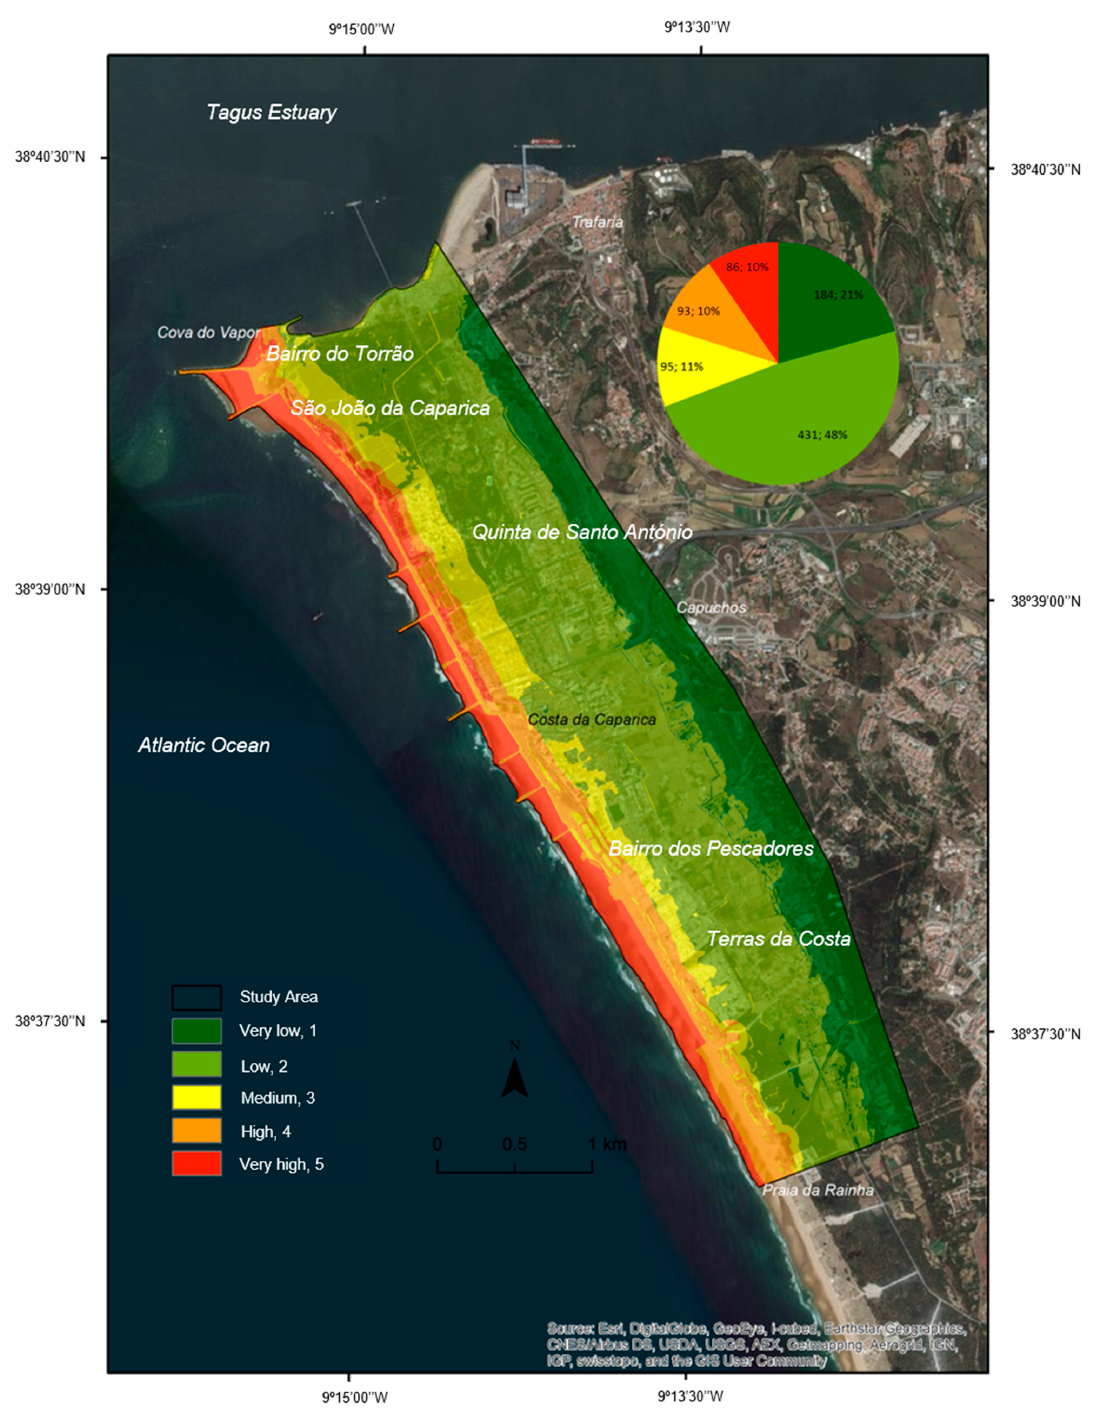
Figure 4. Map of the hazard index to coastal overtopping and consequent flooding in the study area, Costa da Caparica, with the graph with the areas (ha) and percentages of each class of vulnerability. The coordinate system used was the Datum73 Transverse Mercator.